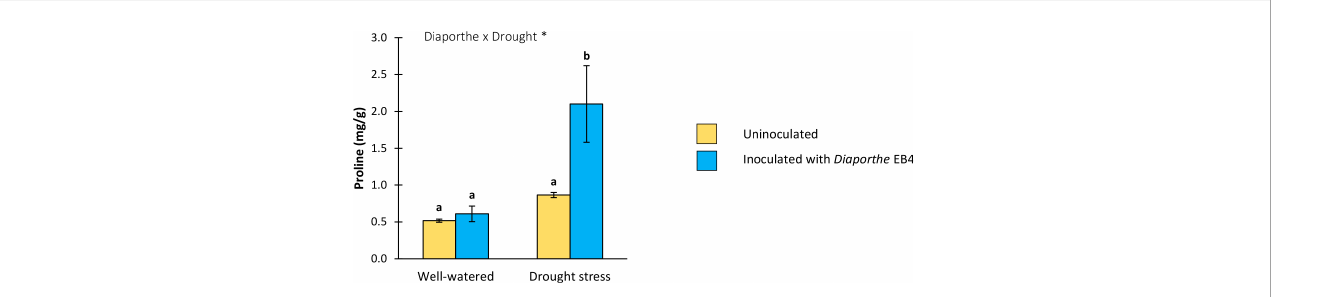
FIGURE 6 Proline content in leaves of tomato plants uninoculated (yellow) or inoculated with Diaporthe EB4 (blue), with two different water treatments (well- watered or drought stress). Different letters indicate different means (Tukey p <0.05) for the [ Diaporthe inoculation × Drought] interaction. Values are means +SE (n=5). Level of signi fi cance: * p <0.05.